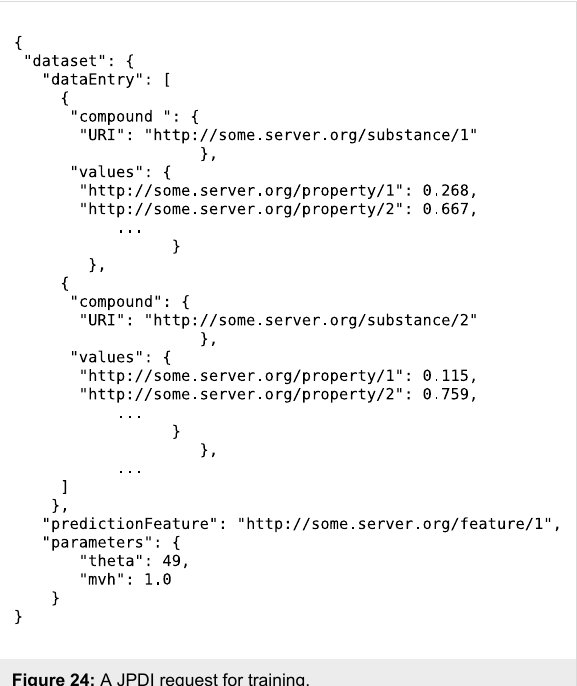
Figure 24: A JPDI request for training.